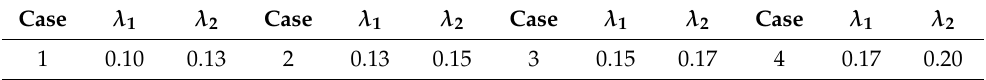
Figure 12. The Markov structure M for modeling the changing VARs. Table 3. Combinations of the VARs λ 1 and λ 2